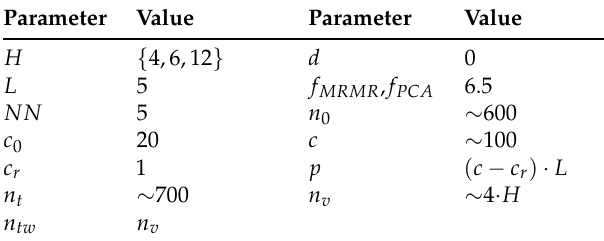
Table 4. Experimental setup: Case B.